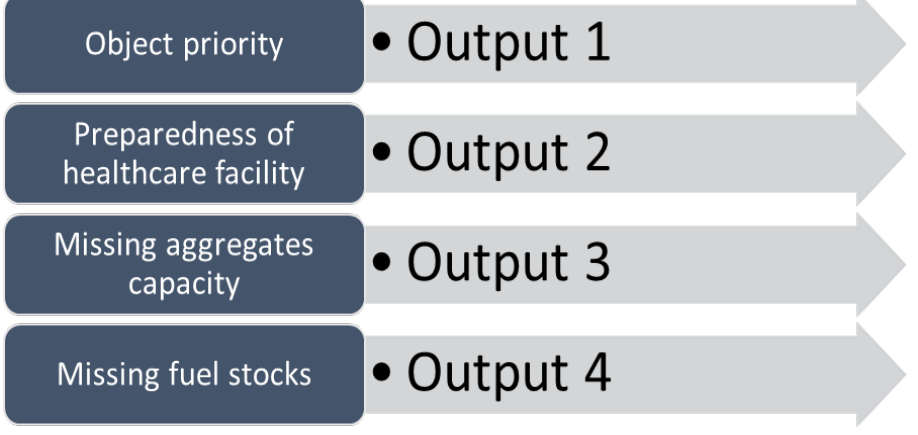
Figure 3. Outputs.